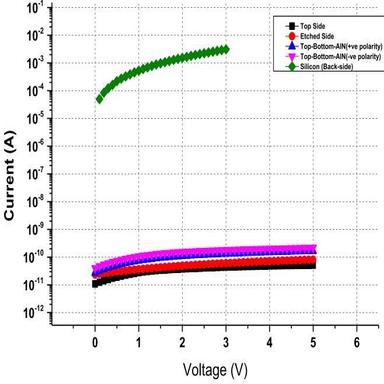
Current-Voltage characteristics of AlN stack.